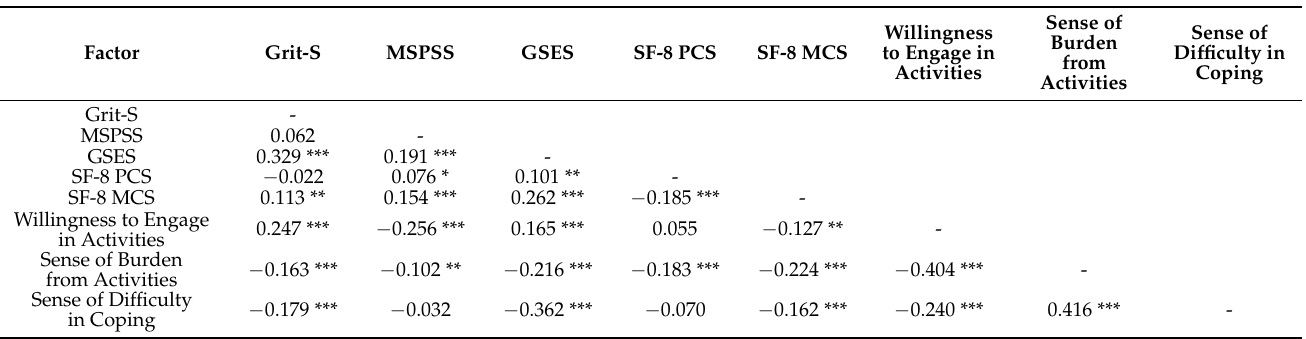
Table 4. Correlations among factors related to willingness to engage in